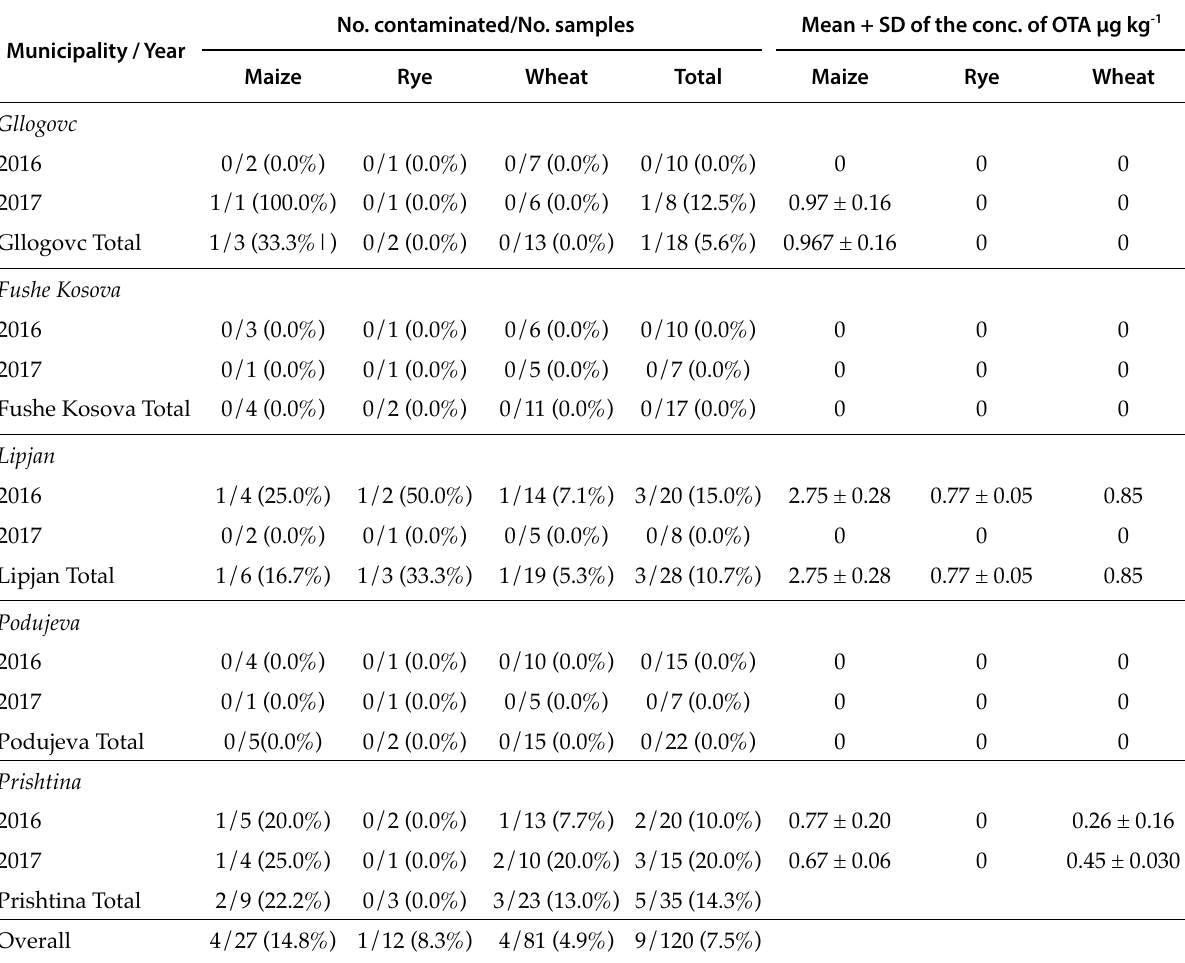
Table 5. The OTA contamination of flour in each municipality in 2016 and 2017. Municipality /